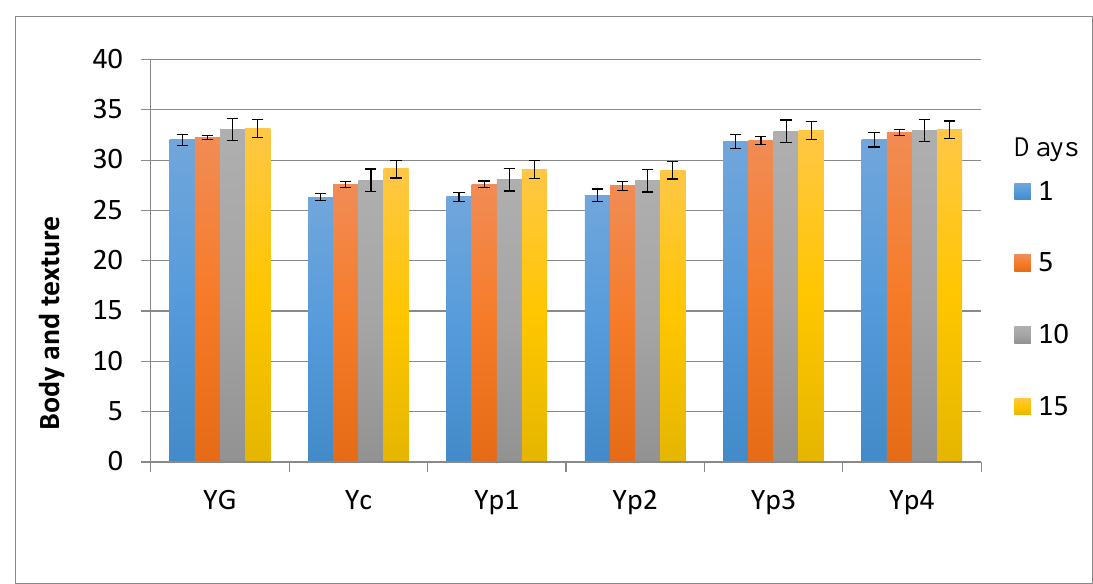
Figure 3. Mean values of yogurt’s appearance during storage.